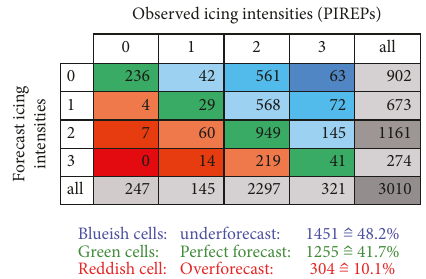
Figure 5: Multicategory contingency table for the mean method using point data